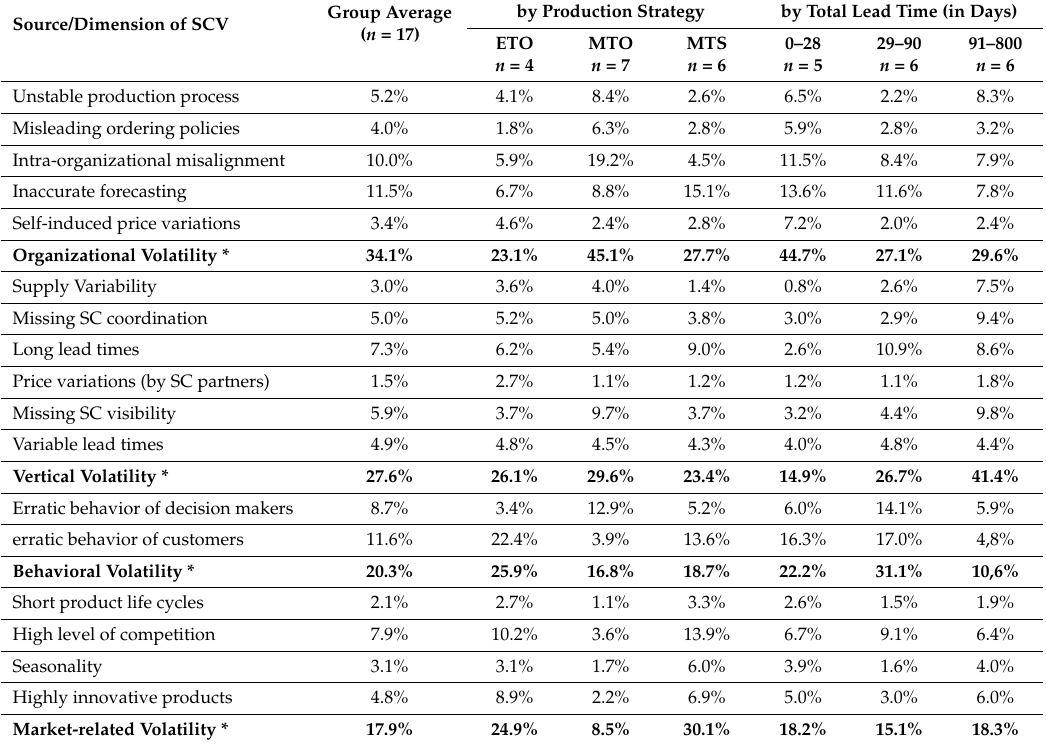
Table 3. Overview of AHP results.